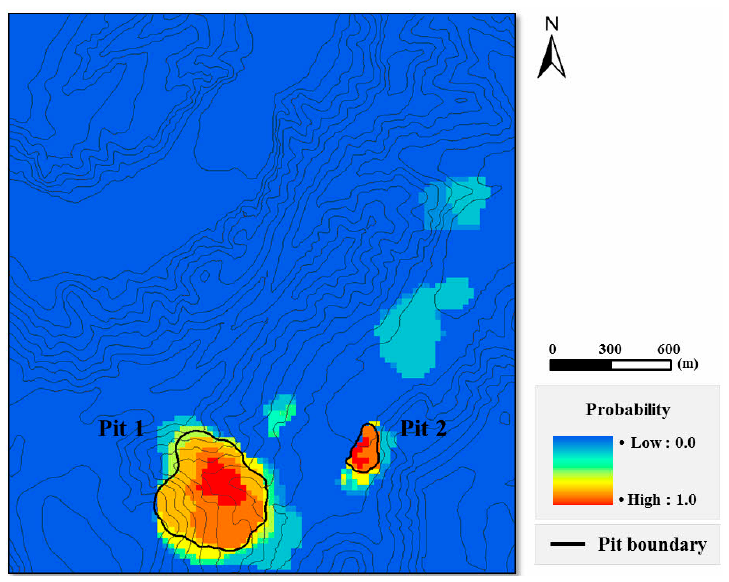
Figure 9. Probability model representing the uncertainty in the pit optimization results.